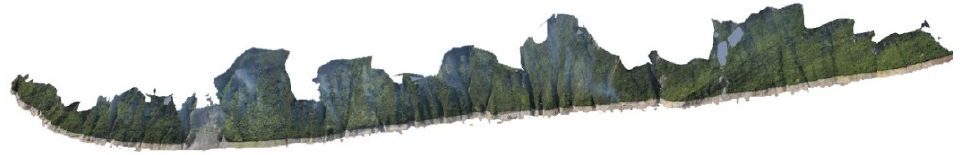
Figure 10. Shipborne photogrammetric 3D model of the left bank of Wushan from the Yangtze River Bridge to